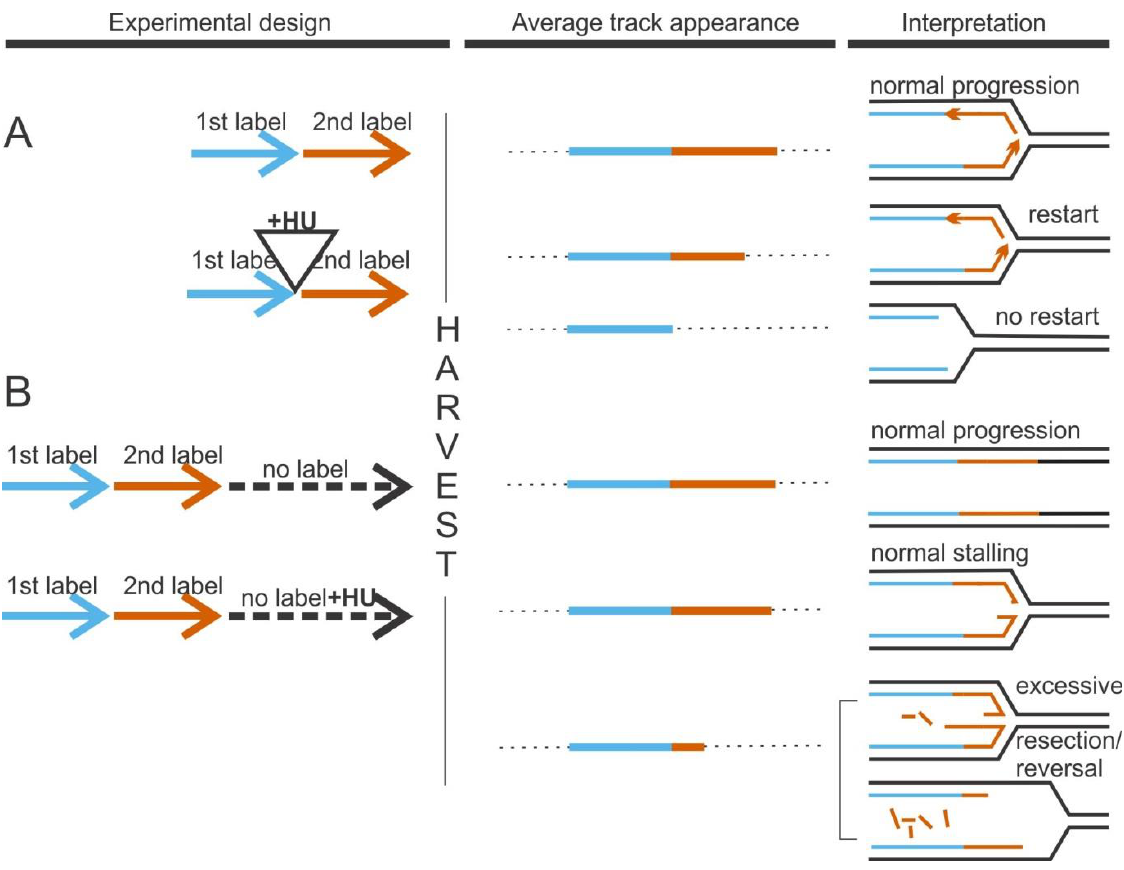
FIGURE 1: DNA fiber analysis detects faulty fork activity. In a “classic” experiment to measure fork restart (A) , cells are sequentially pulse- labeled for 15-30 min each with two nucleoside analogs, typically, chloro-deoxyuridine and iodo-deoxyuridine. In test samples, incubation with a fork-arresting dose of hydroxyurea (HU), a ribonucleotide reductase inhibitor, is introduced between the labels. Failure to restart after HU manifests as preponderance of tracks containing only 1 st label. One way to measure degradation of nascent strands at stalled forks (B) , is to follow sequential pulse-labeling with two labels by a label-free chase (usually 4-6hrs). In test samples, HU is introduced during this time. Extensive loss of nascent DNA manifests as shortening of 2 nd label segments in tracks labeled prior to HU